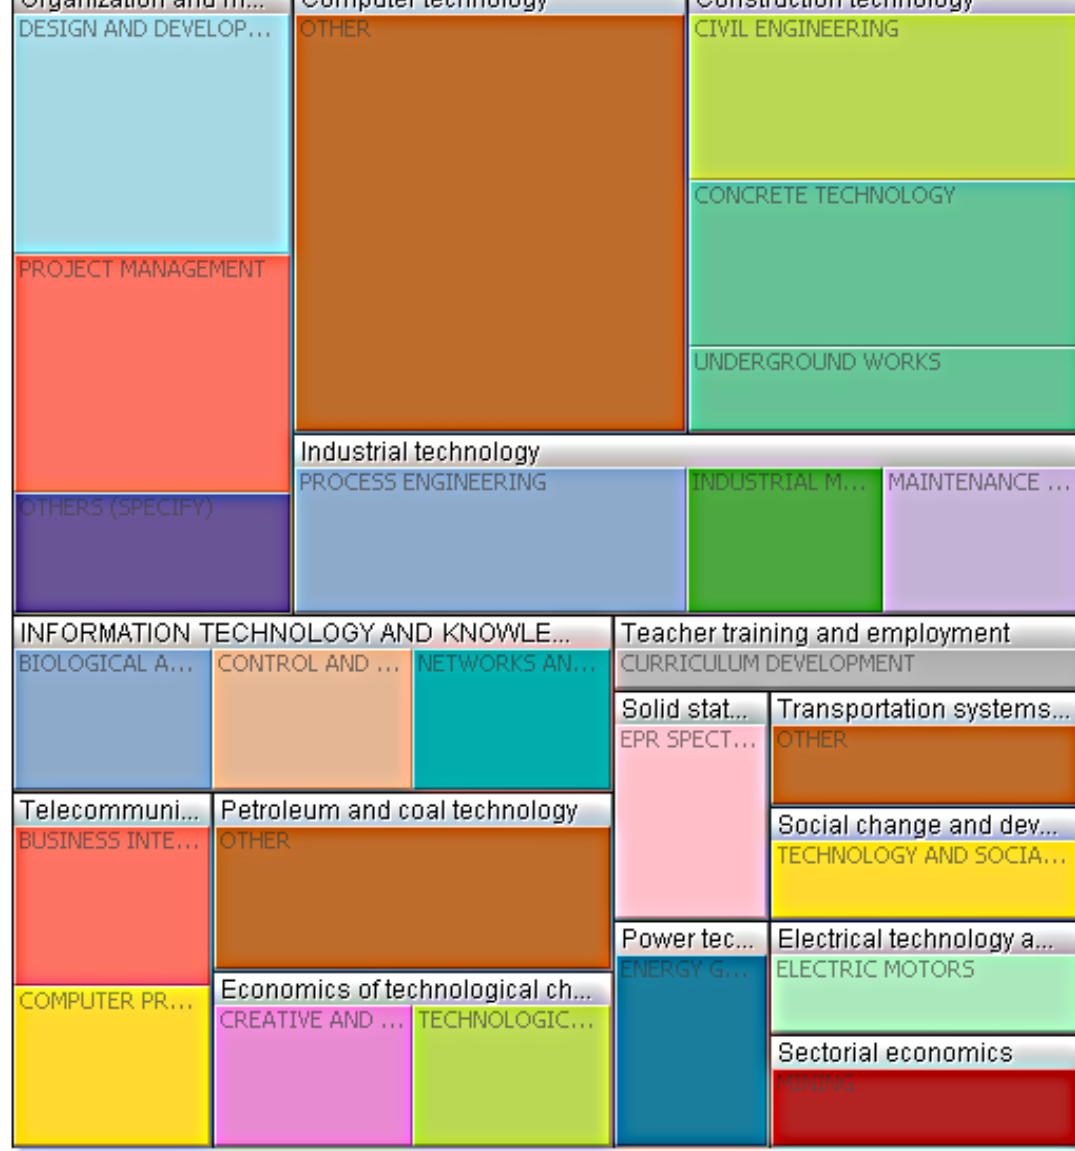
Figure 2. Diagram of the JCR impact obtained by each of the disciplines and sub-disciplines of the DYNA Journal [27].